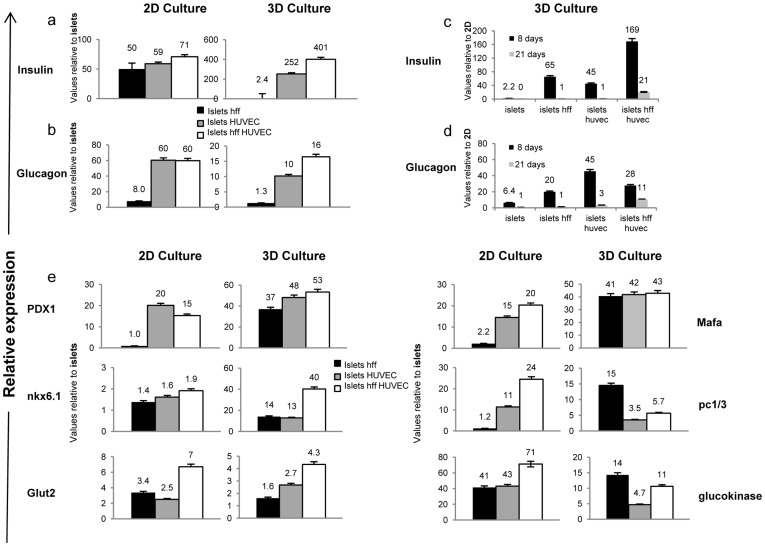
Addition of endothelial cells to islet cultures promotes islet function in vitro.
Real-Time PCR analyses of (a) insulin and (b) glucagon were performed on islets cultured in 2D or 3D microenvironments for 8 days, in the absence or presence of HFF and/or HUVEC. Values were normalized to mouse 18s and are presented as the recorded levels versus those of free islets cultured under the same conditions. Differential expression analyses of (c) insulin and (d) glucagon were performed by comparing their levels in 3D versus 2D islet culture on days 8 and 21. Values were normalized to mouse 18s RNA and are presented as the ratio of levels expressed in 3D versus 2D islet culture environments. (e) Real-Time PCR analyses of the mature islet genes PDX1, NKX6.1, GLUT2, MAFA, PC1/3 and glucokinase were performed for islets cultured in 2D and 3D microenvironments, in the absence or presence of HFF and/or HUVEC. Values were normalized to mouse 18s and are presented as the ratio of the recorded levels versus those of free islets cultured under the same conditions.